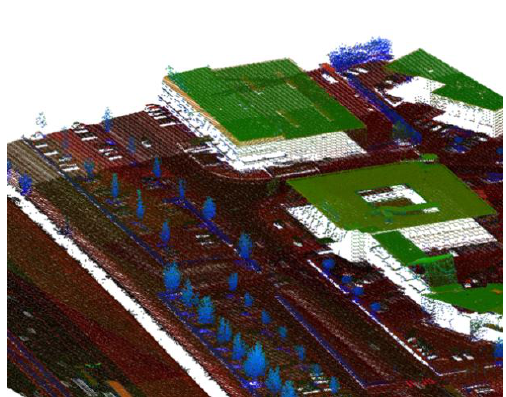
Figure 2. RGB colour has been replaced by three features, namely point intensity, return number, and height with respect the lowest point in a neighbourhood. Visually, it can be seen that the ground has a false colour easily distinguishable from other points The data organization parameters were also modified, as originally each point cloud was sampled into 1x1m blocks. Given that the density of the aerial point clouds is smaller, and the surface covered much larger, the block surface was set to 10x10m, with a stride of 7.5m, which allows to capture efficiently the local geometric properties of the point cloud in each block. A total of 4096 points are sampled from each block in order to define data batches with a consistent number of